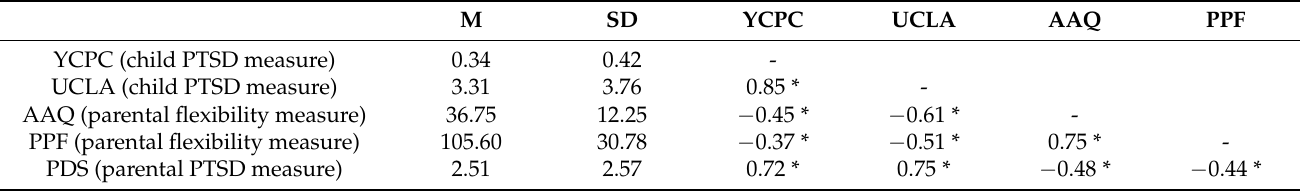
Table 2. Descriptive statistics and Pearson correlations.